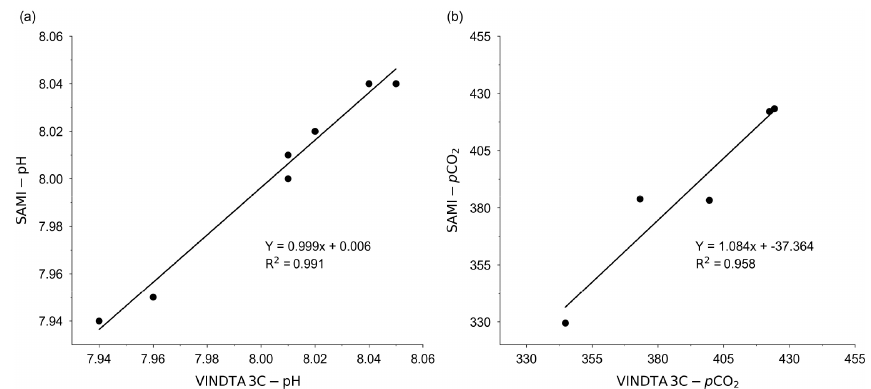
Figure 3. Validation of in situ measurements of pH (a) and p CO 2 (b) using discrete water samples. SAMI sensors measured pH and p CO 2 directly in the water column. The pH and p CO 2 values used for validation were calculated with the CO2SYS program as a function of measured TA and DIC; discrete samples were measured with a VINDTA 3C